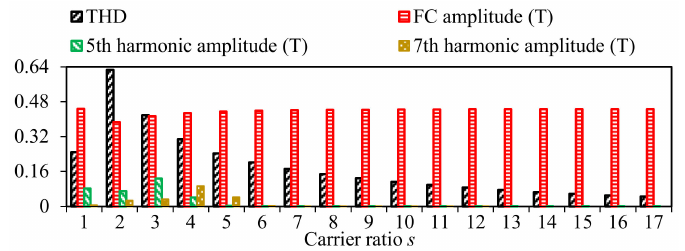
Figure 6. Features of B we s m1 y versus the carrier ratio s for Array I.